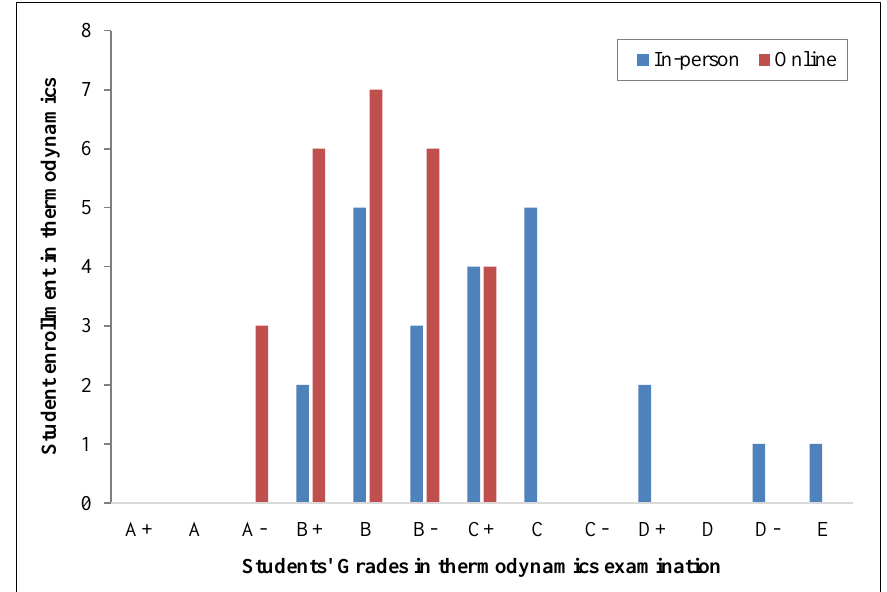
Figure 4. Grade distribution in Thermodynamics course in virtual and in-person learning